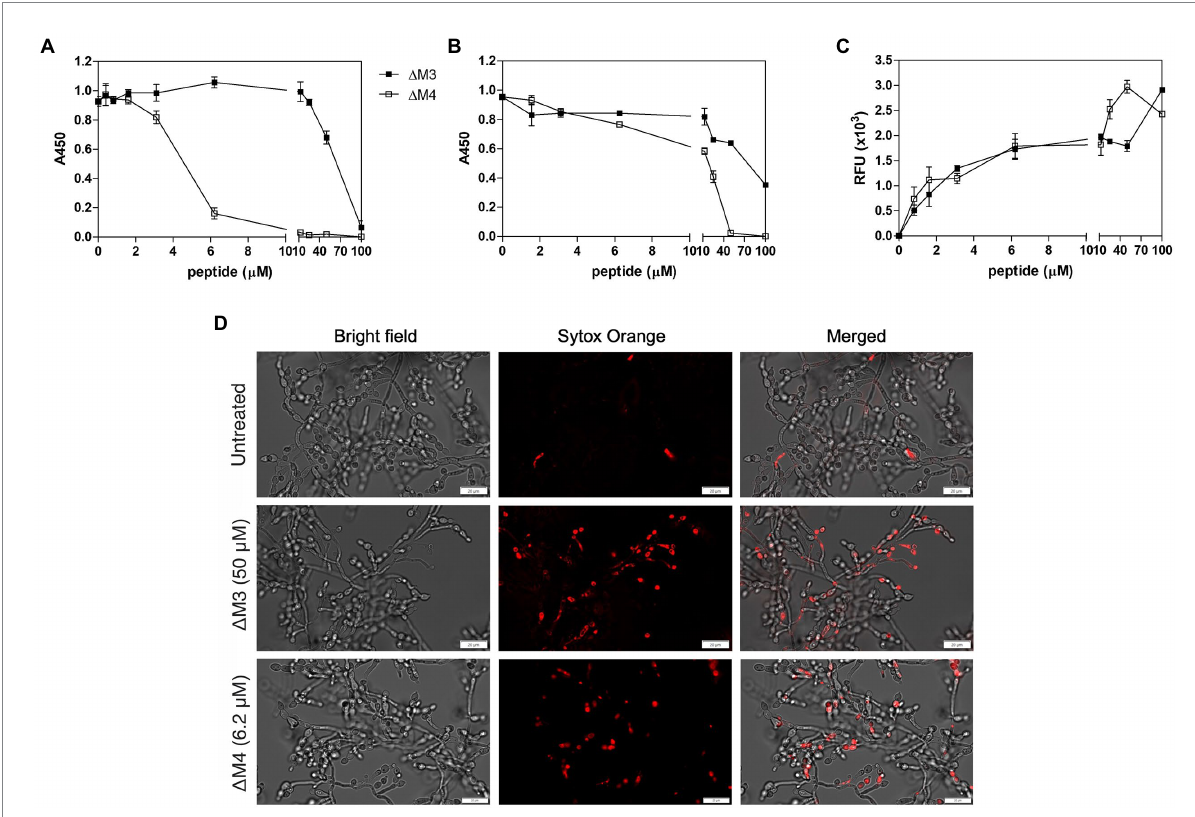
FIGURE 6 Effect of Δ M3 and Δ M4 on C. albicans biofilm. (A) The effect of peptides on biofilm formation was performed with C. albicans cells (1 × 10 5 /100 μ l) incubated in RPMI 1640 medium with peptides at concentrations in a range of 0.4–100 μ M for 24 h at 37 ° C in a microplate wells, after